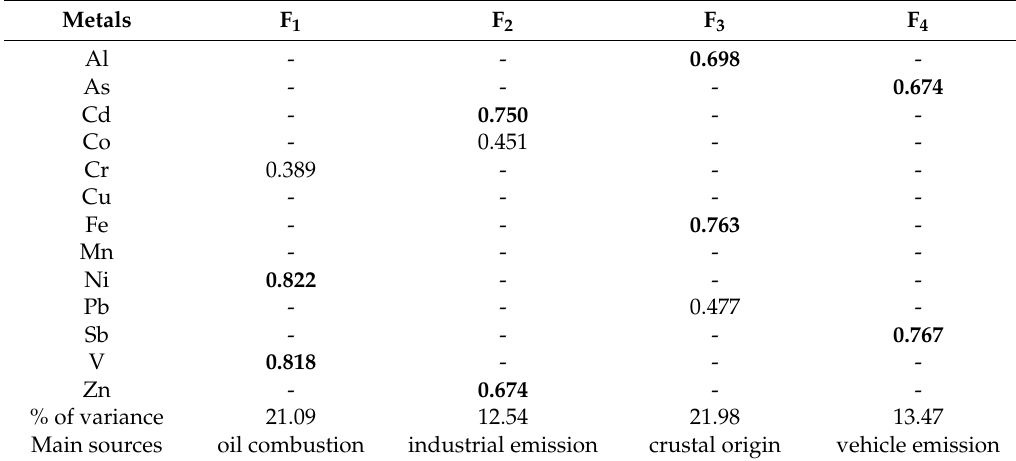
Table 6. PCA factor loadings for PM 10 in